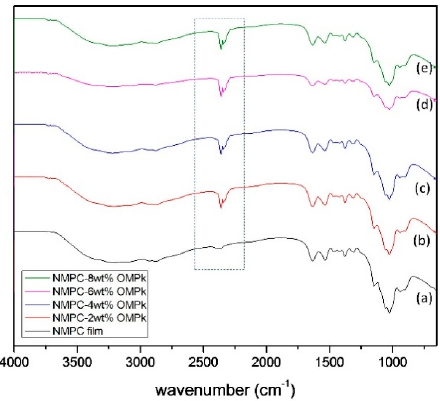
Figure 6. FTIR spectra of the solid polymer electrolytes (SPEs): ( a ) N -methylene phosphonic chitosan (NMPC) film, ( b ) NMPC-2 wt % O -methylene phosphonic κ -carrageenan (OMPk), ( c ) NMPC-4 wt % OMPk, ( d ) NMPC-6 wt % OMPk, and ( e ) NMPC-8 wt % OMPk.